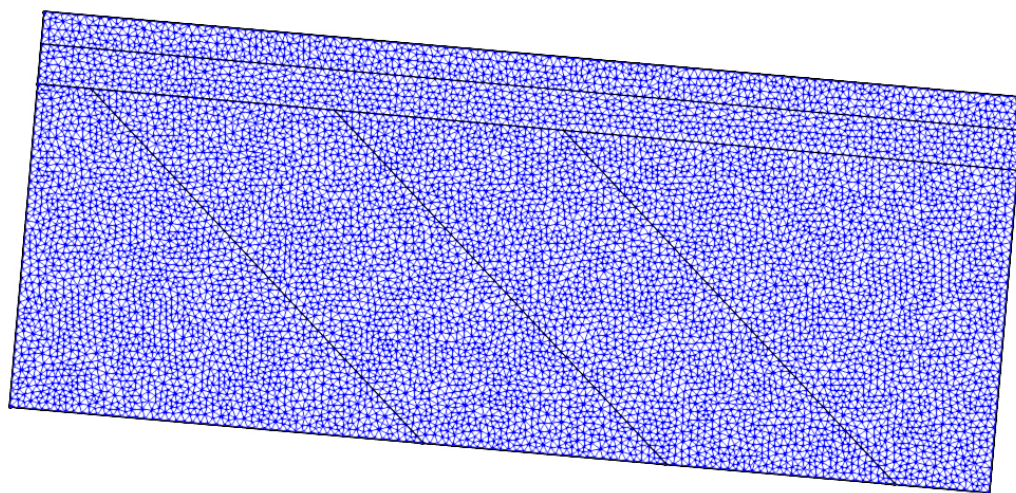
Figure A3. Triangular mesh with zone outlines used for the numerical model. The mesh file used in numerical simulations consisting of 16,602 cells sloped at a 5° angle. The cells have an average representative elemental volume of 1.4 cm 3 . This unstructured grid allows for the influence of a 5° FCL slope to be investigated, as well as the effects of internal sloped boundaries following the angle of repose.